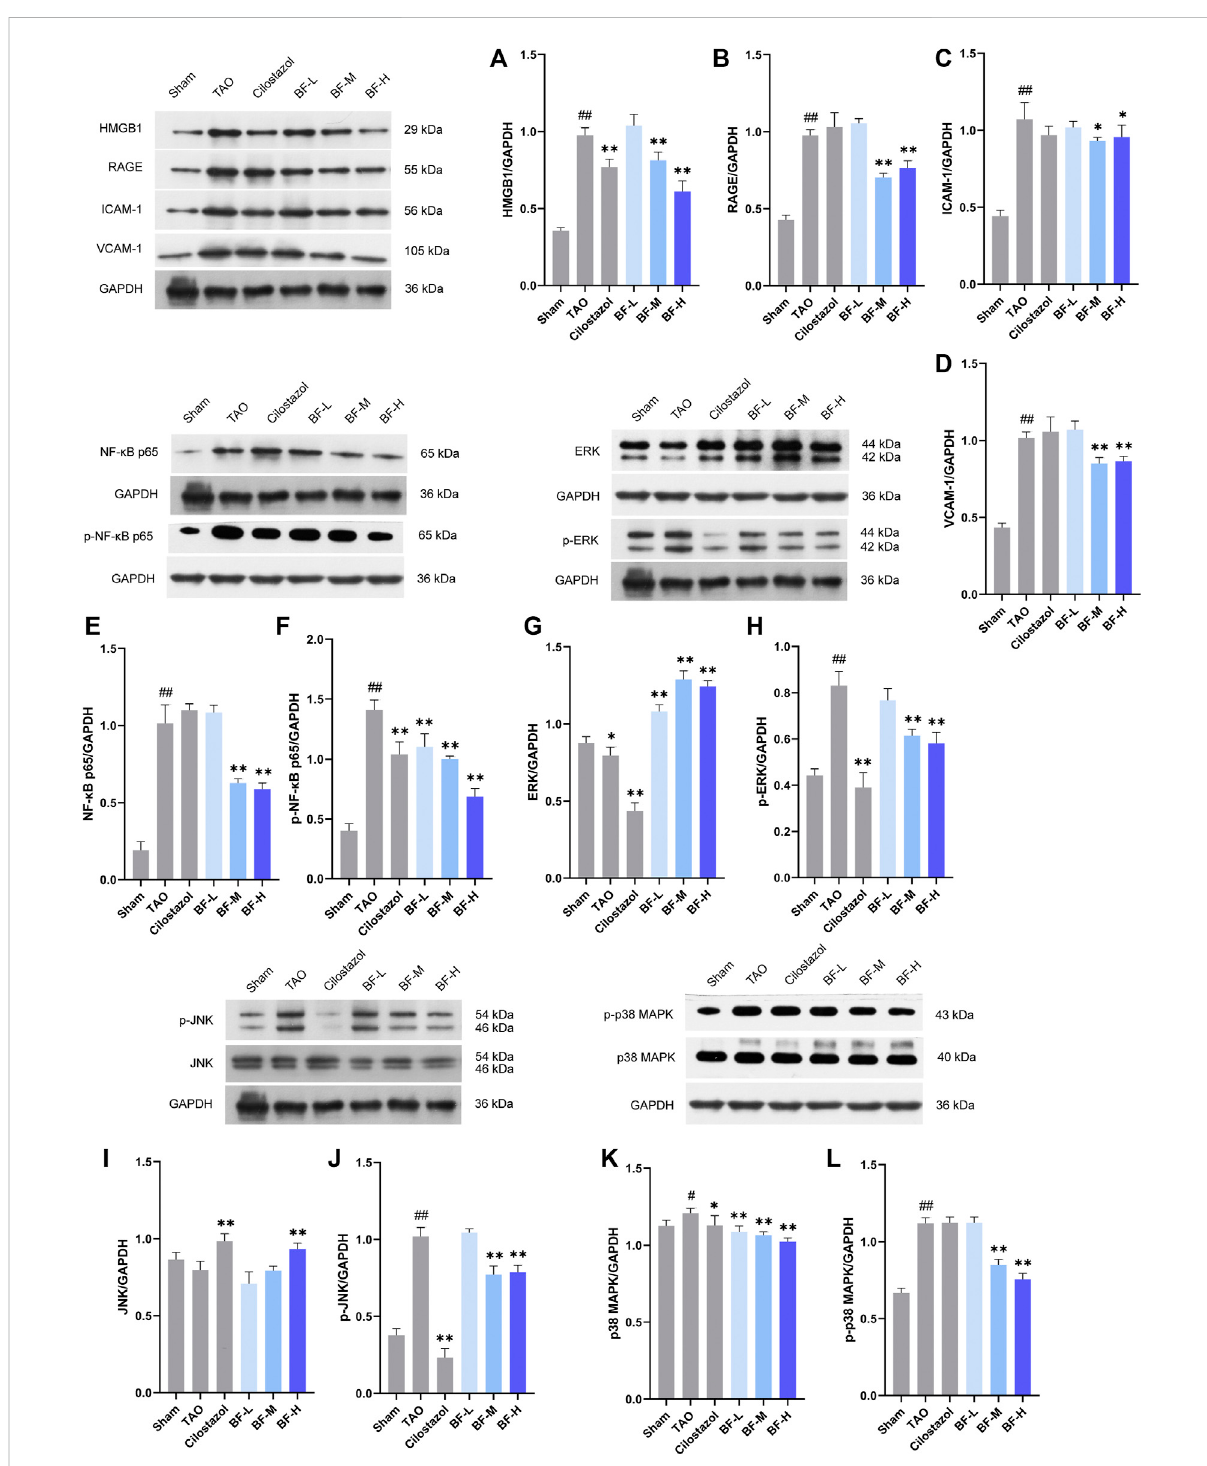
FIGURE 6 Effects of Baiying Qingmai formulation (BF) on proteins and signaling pathways of the in fl ammatory response. Levels of (A) HMGB1, (B) RAGE, (C) ICAM-1, (D) VCAM-1, (E) NF- κ B p65, (F) phosphorylated NF- κ B p65, (G) ERK, (H) phosphorylated ERK, (I) JNK, (J) phosphorylated JNK, (K) p38 MAPK, ( L ) phosphorylated p38 MAPK in the femoral artery. Data are presented as mean ± SEM ( n = 3). # p < 0.05, ## p < 0.01 versus the Sham group,* p < 0.05,** p < 0.01 versus